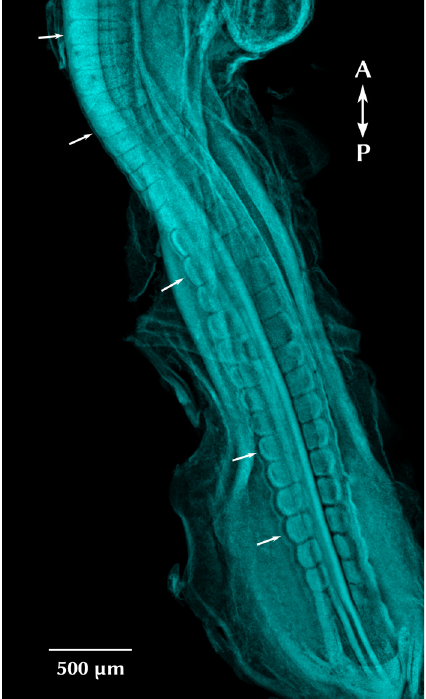
Figure 1. Chick embryo showing the segmented pattern along the anterior-posterior (A-P) axis. Embryo stage HH17, corresponding to 30 pairs of somites (age 52–64 hours). Dorsal view, stained with DAPI (cyan). Arrows indicate individual somites in different maturation